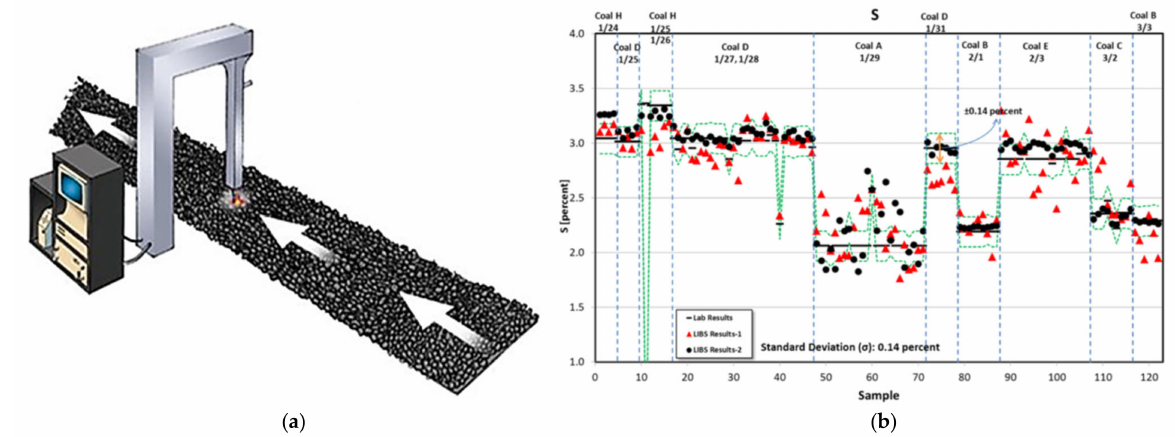
Figure 5. LIBS in-line analyzer of coal. ( a ) Schematic of measurement system for coal on conveyor belt in coal-fired power plant. ( b ) Measured concentration of Sulphur in coal for approx. 120 samples (validation tests). Adapted from [452,453].